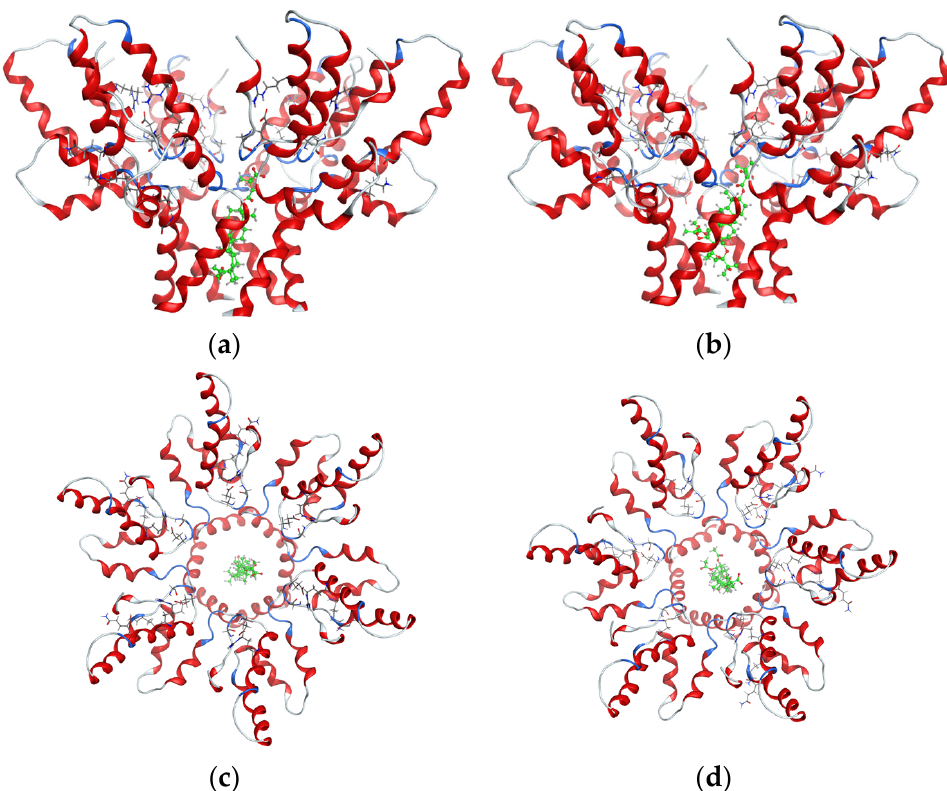
Figure 4. Docking results of CA-SP1 protein (PDB code: 5I4T) binding with ligands (green), BVM ( a , c ) and DSC ( b , d ) from a side and top view, visualized with MOE program. a , b , Side view ( a , b ) showing that BVM was vertically bound to the center of the 6HB in a linear extended conformation while DSC was slightly inclined to the center of the 6HB. c , d , Top view ( c , d ) displaying both BVM and DSC located in the cavity formed by the CA-SP1.